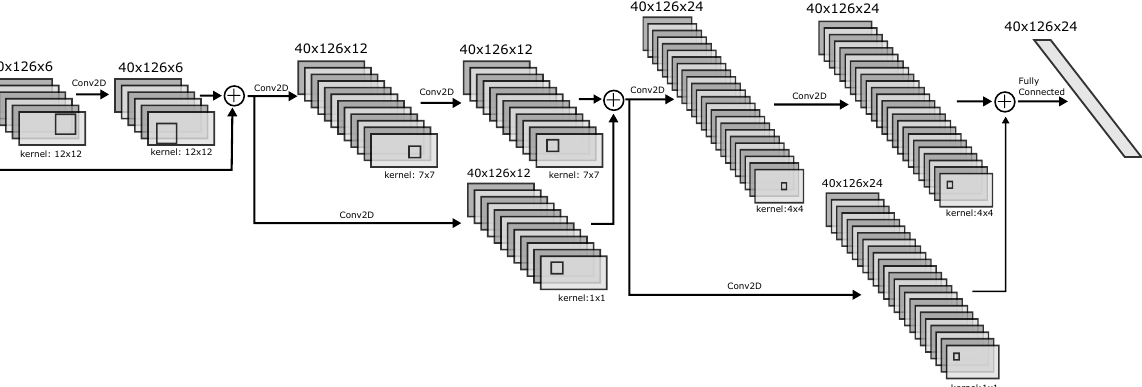
Figure 6. Detailed architecture of the CNN path for one channel. The network contains four of these in